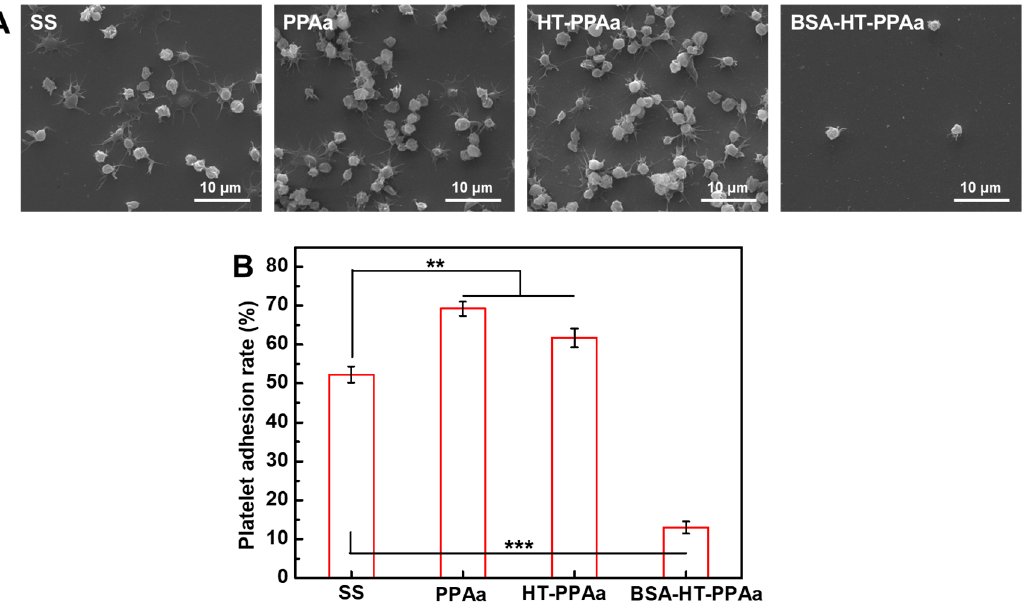
Figure 10. ( A ) The platelet adhesion rate of SS, PPAa, HT-PPAa, and BSA-HT-PPAa film. ( B ) Data are presented as mean ± SD ( n = 4) and analyzed using one-way ANOVA (* p < 0.05, ** p < 0.01, and *** p < 0.001).